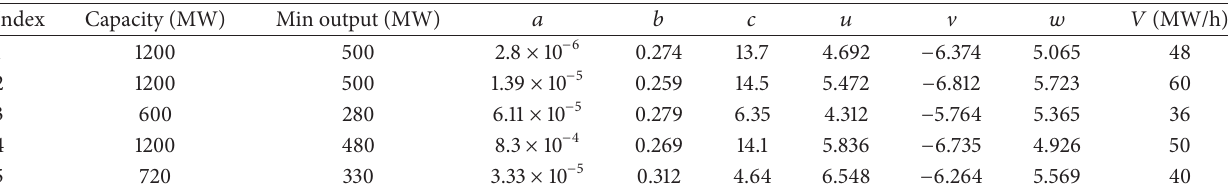
Table 1: Basic parameters of thermal power plants.